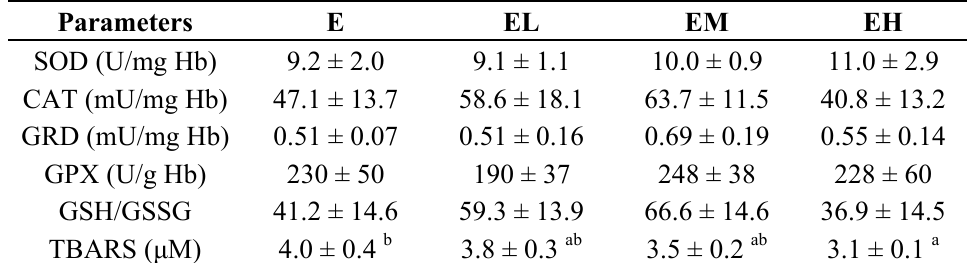
Table 3. G. tsugae effect on antioxidant enzymes activities and GSH/GSSG of erythrocytes and plasma TBARS after exhaustive